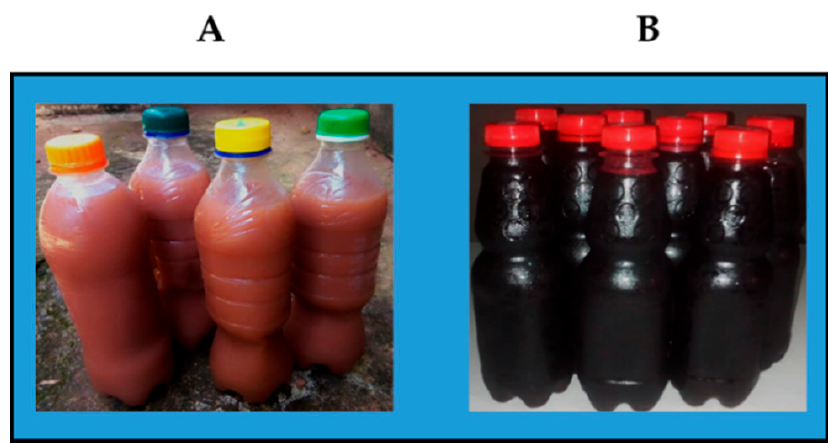
Figure 2. Popular unregulated soft drinks in Nigeria. Production of kunu ( A ) and zobo ( B ) is usually carried out from the home or other unregistered facilities.